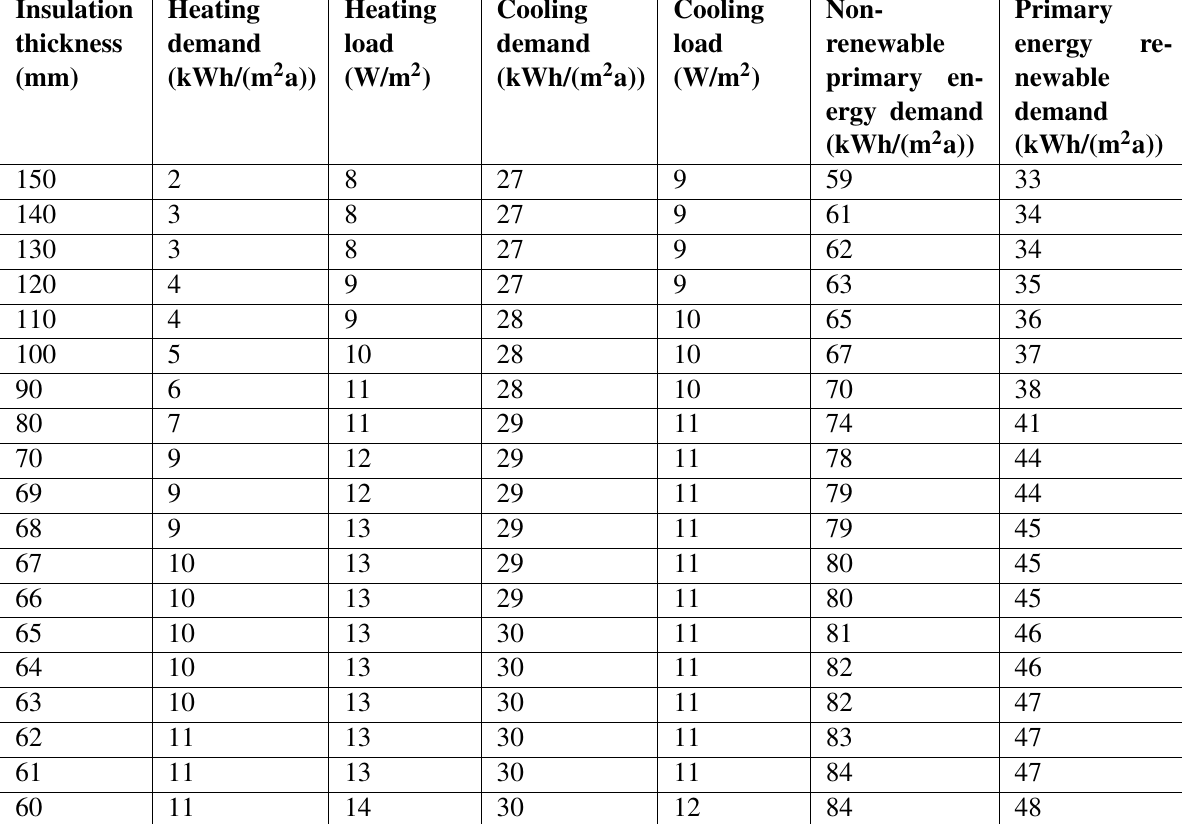
Table 1 Analysis of the influence of insulation thickness on energy consumption.